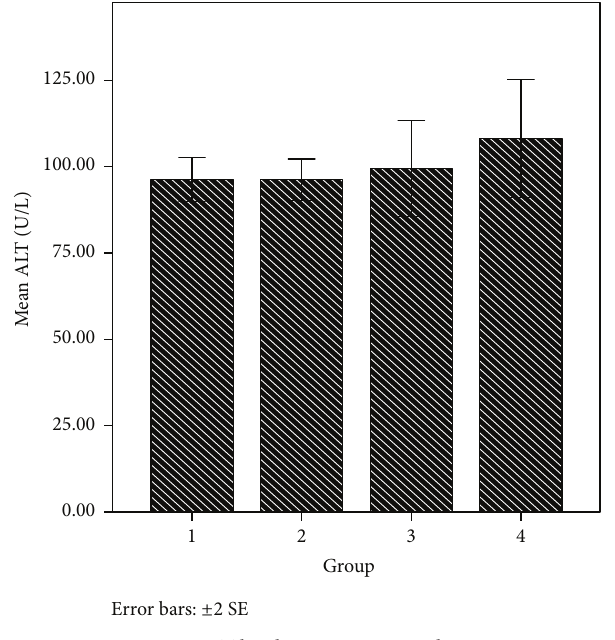
Figure 8: ALT level in various animal